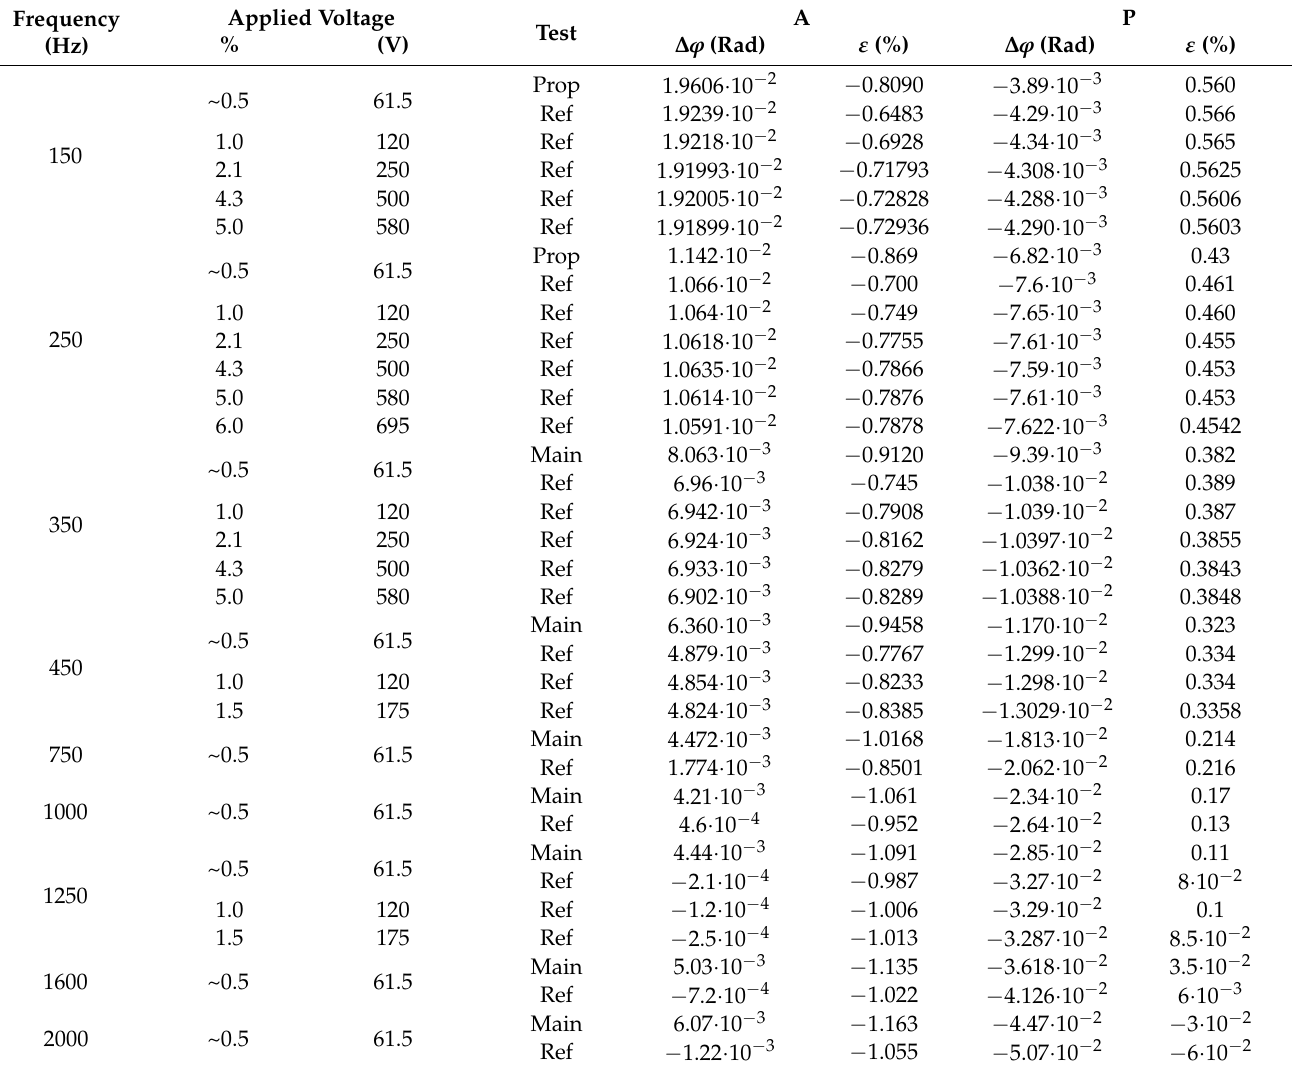
Table 5. Measurement results from the characterization procedure and the validation test.